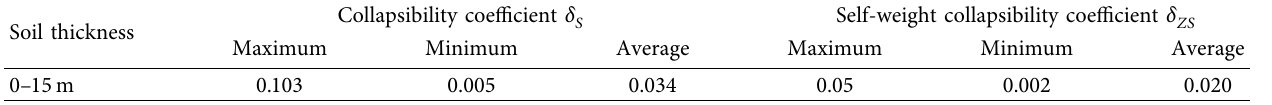
Table 1: Physical parameters of loess.